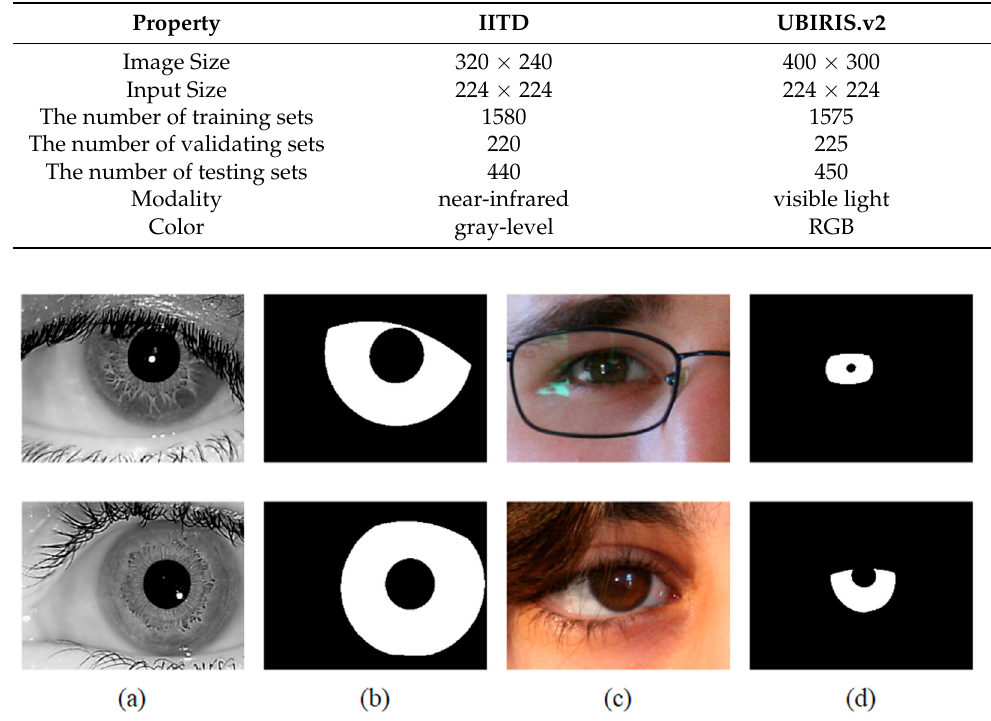
Figure 7. Image samples from the adopted iris databases ( a ) IITD, ( b ) Ground-truth masks of IITD, ( c ) UBIRIS.v2, ( d ) Ground-truth masks of UBIRIS.v2.